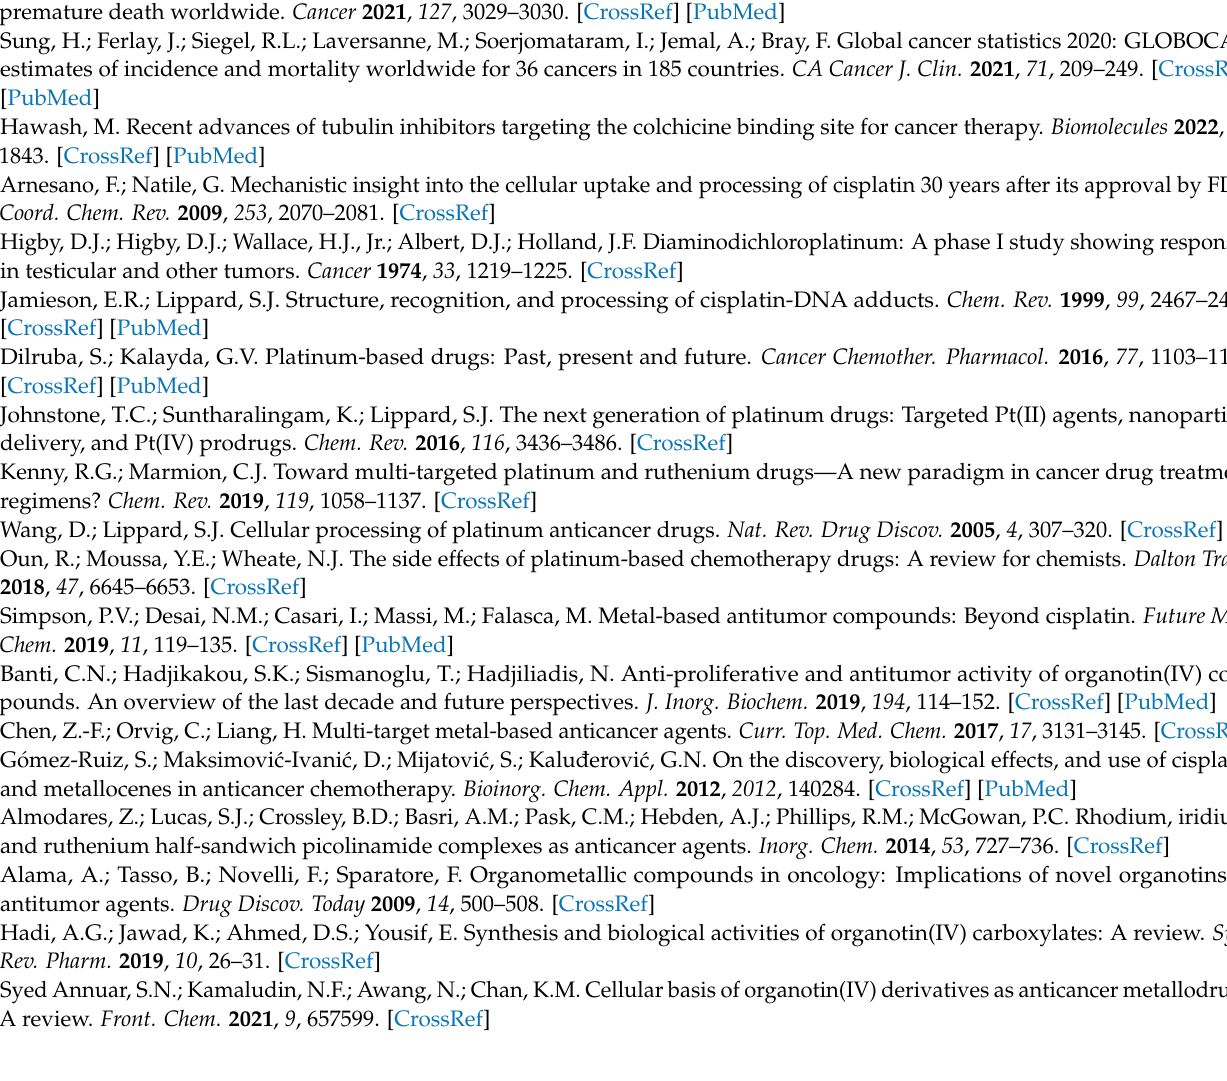
Figure S16: Cell viability of [Ph3Sn(IND)], [Ph3Sn(FBP)] and cisplatin determined by MTT and CV assays in BT-474 breast cancer cell line; Table S1: Crystal data and structure refinement of [Ph 3